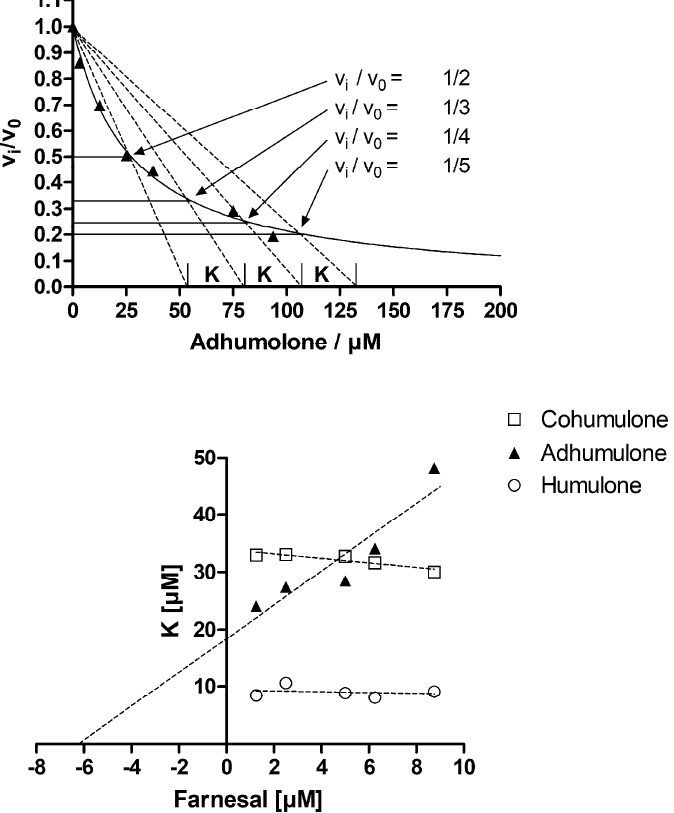
Figure 4. Determination of inhibition mode. To determine the mode of inhibition the normalized velocity is plotted as a function of inhibitor concentration as exemplified in the upper diagram (farnesal = 1.25 µM). The data were fitted to v i /v 0 = 1/(1 + ([I]/IC 50 )) and lines are drawn from [I] = 0 to the intersection of v i /v 0 = 1 / 2 and so on. The intersection of the dotted lines with the x-axis define the